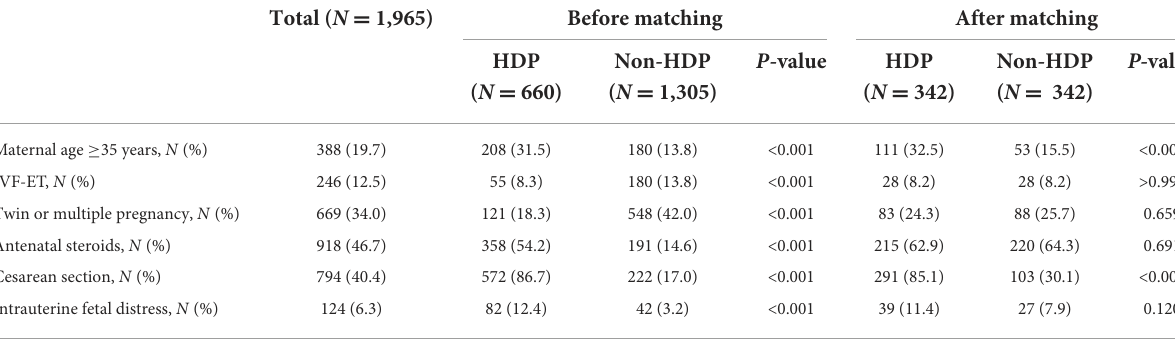
TABLE 2 The maternal characteristics in HDP and non-HDP